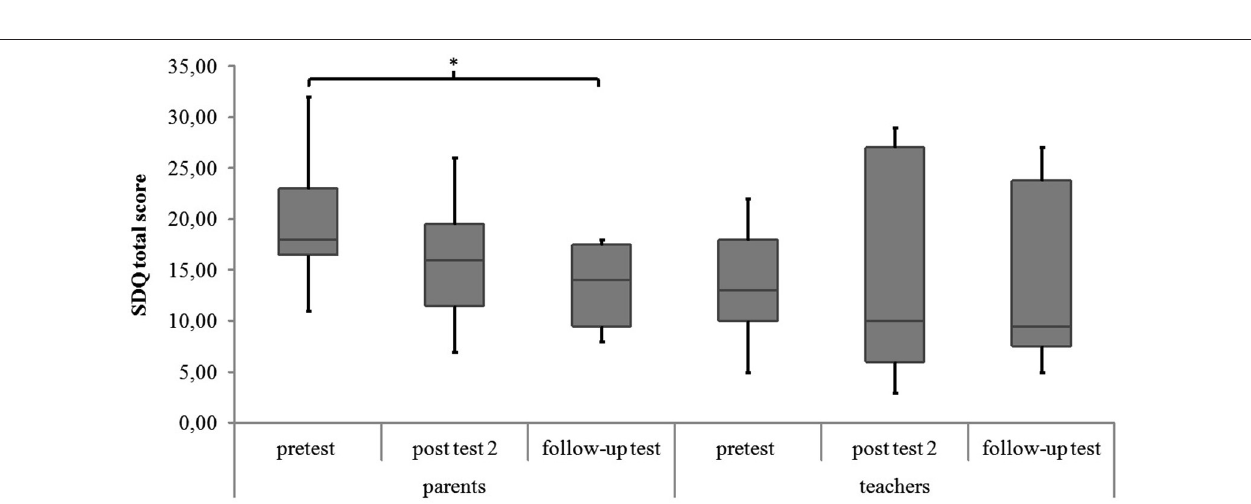
FIGURE 4 | SDQ total score of parents’ and teachers’ ratings for all measurement points . Middle line of boxes = median, box = interquartile range, error bars = minimum respectively maximum, * =